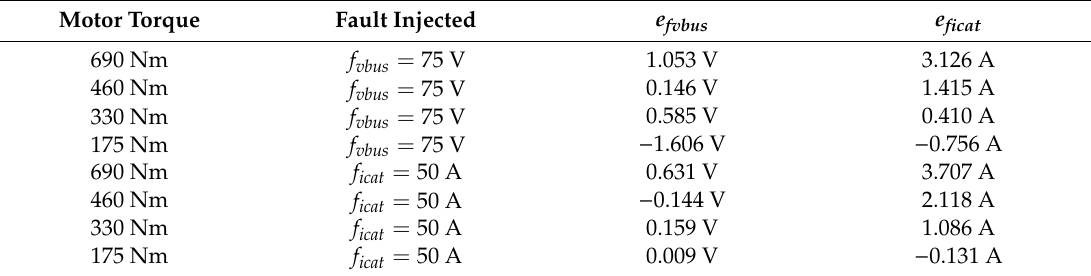
Table 4. Summary of deviation between fault injected and fault reconstruction average